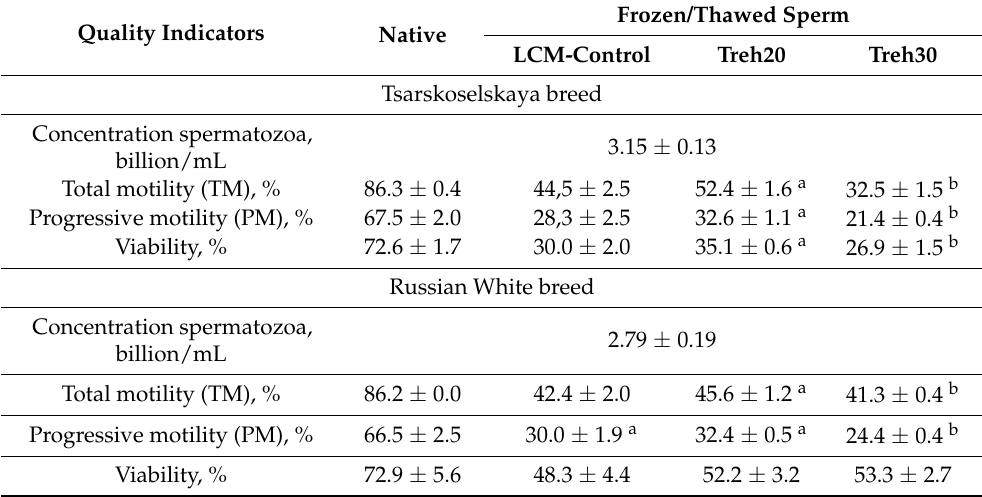
Figure 4. Dynamics of the degree of unsaturation of fatty acids in plasma membranes of spermatozoa of native and frozen/thawed semen depending on the composition of the cryoprotective diluent: ( a ) Tsarskoselskaya breed; ( b ) Russian White breed. Table 4. The morphological and functional features of the native and frozen/thawed rooster semen depending on the composition of the